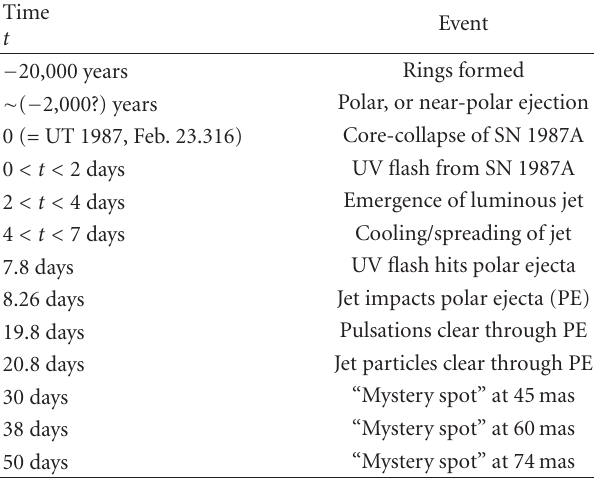
Figure 2: The geometry of the “Mystery Spot,” (red dot) polar ejecta, associated beam/jet, and direct line of sight from SN 1987A to the Earth.